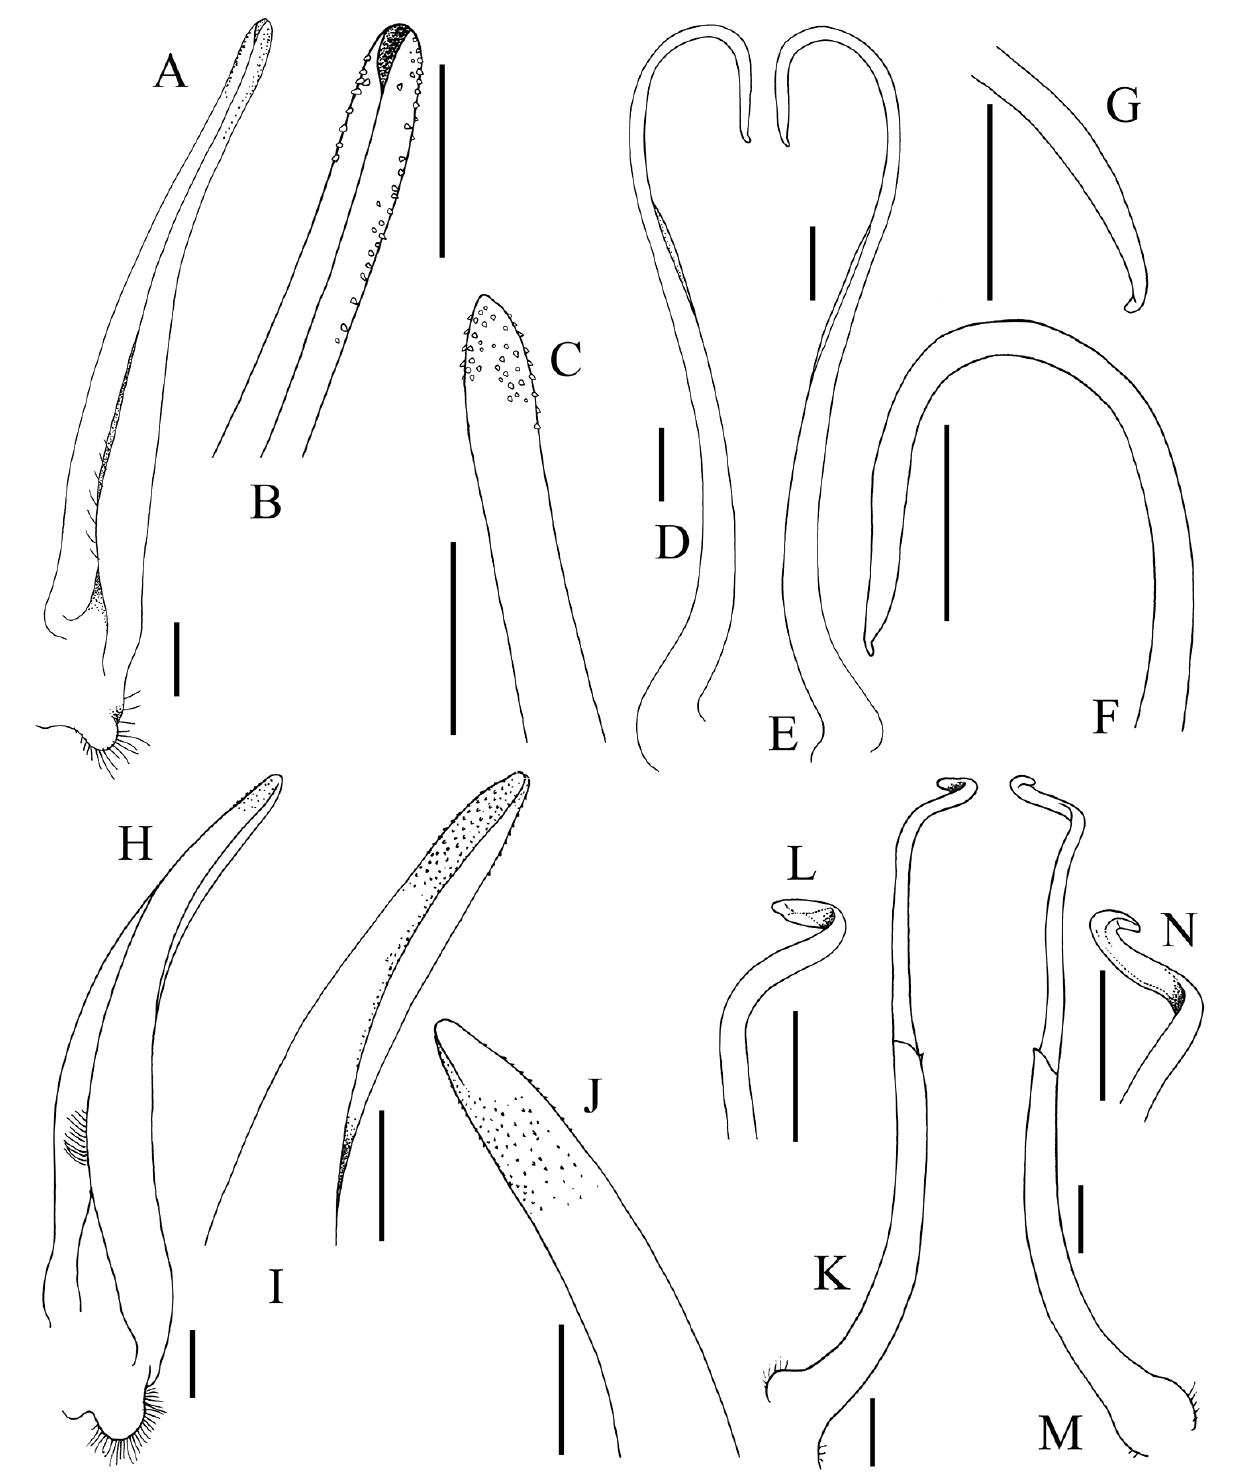
Figure 4. A – G , Mursia bicristimana Alcock and Anderson, 1894, young male (37.2 × 19.6 mm) (ZRC 2017.0134); H – N , M. spiridonovi Karasawa, 2018, male (23.9 × 14.6 mm) (ZRC 2019.0492). A , H , left G1 (ventral view); B , I , distal part of left G1 (ventral view); C , J , distal part of left G1 (dorsal view); D , K , left G2 (ventral view); E , L , distal part of left G2 (ventral view); E , M , left G2 (dorsal view); F , N , distal part of left G2 (dorsal view); G , distal part of left G2 (dorsomesial view). Scales = 0.5